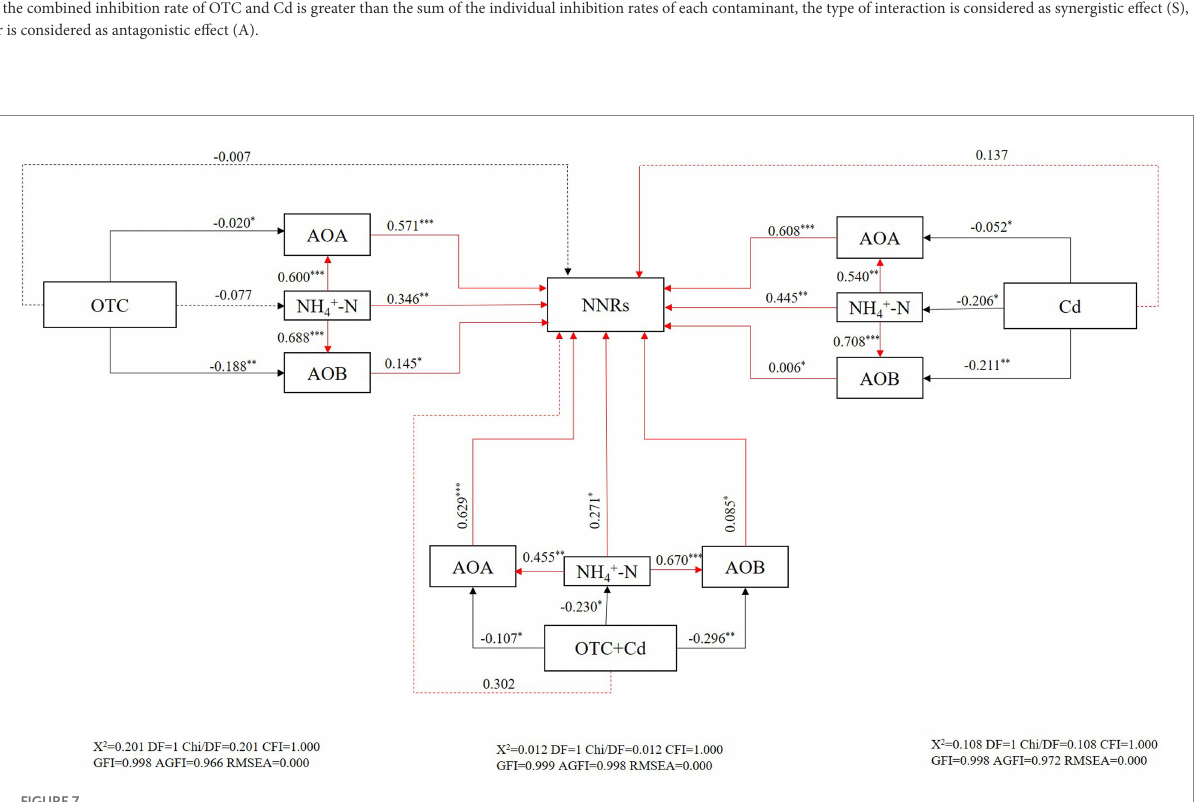
FIGURE 7 Structural equation models (SEM) showing the direct and indirect effects of contamination treatments on AOA, AOB, NH 4+ -N, and NNRs. * indicates significant differences at p < 0.05, ** indicates significant differences at p < 0.01, and *** indicates significant differences at p < 0.001. Numbers on arrows indicate significant standardized path coefficients. Positive effects are represented by red lines, while negative effects are represented by black lines. Continuous and dashed lines represent significant and nonsignificant relationships,